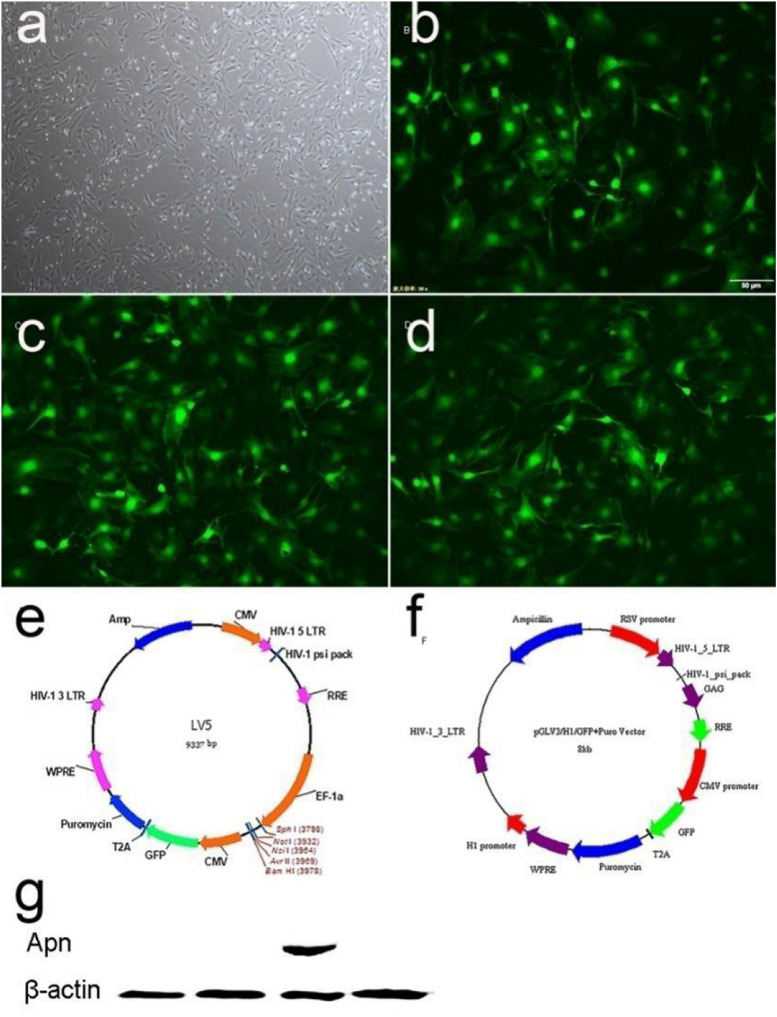
The APN plasmid construction and expression. (a) Morphology characterization of cultured BMSCs (light microscopy). (b) GFP expression in BMSCs 48 h after transduction of empty vector into BMSCs. (c) GFP expression in BMSCs 48 h after transduction of APN into BMSCs. (d) GFP expression in BMSCs 48 h after transduction of APN-siRNA into BMSCs. (e) Maps of LV5. (f) Maps of LV3. (g) Western blotting detection of APN protein expression.